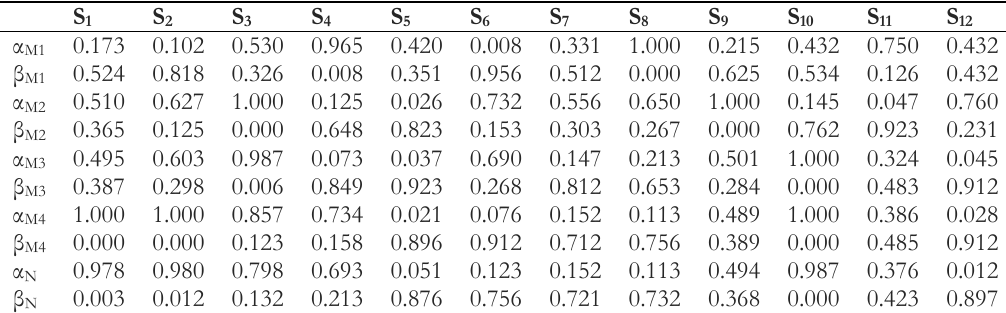
Table 3. Pattern of building materials in